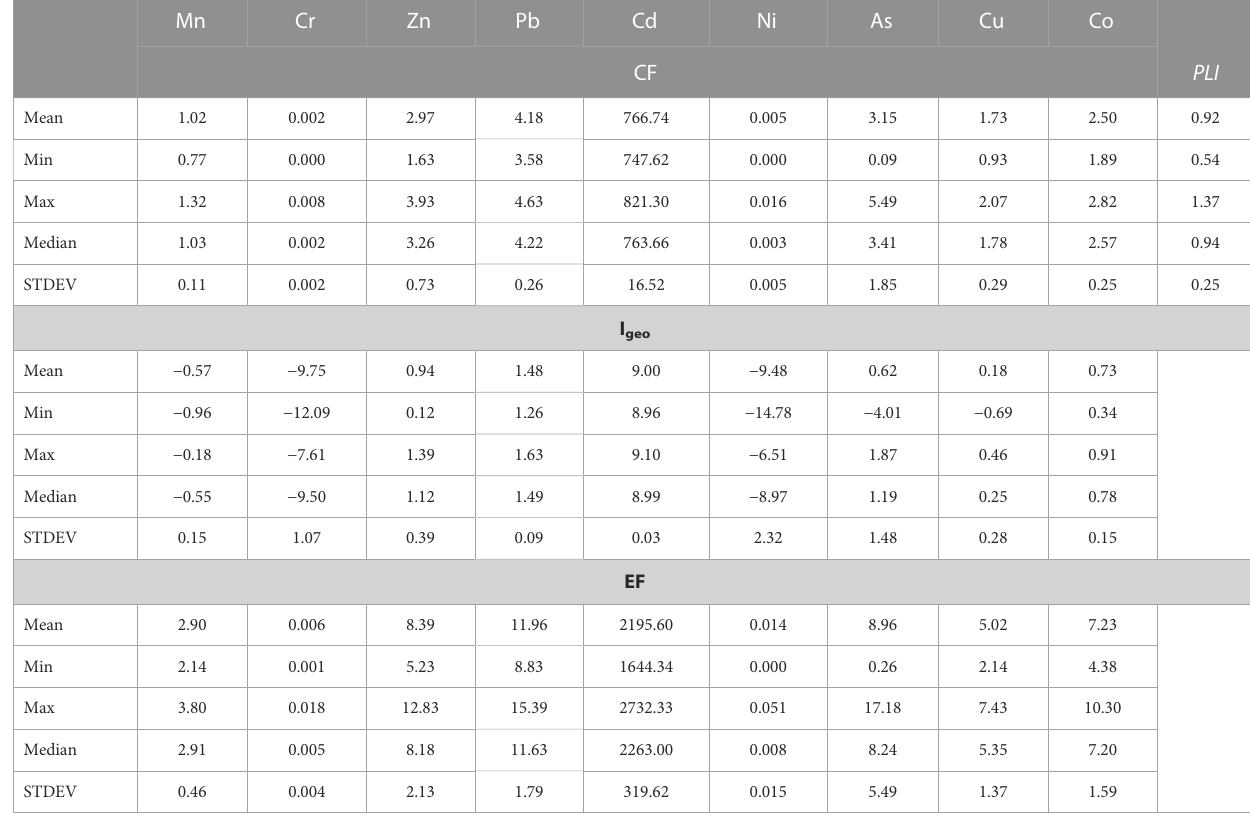
TABLE 4 Summary of the contamination factor (CF) and pollution load index (PLI) for heavy metals in road dust collected from the Abu Dhabi-Liwa Highway.